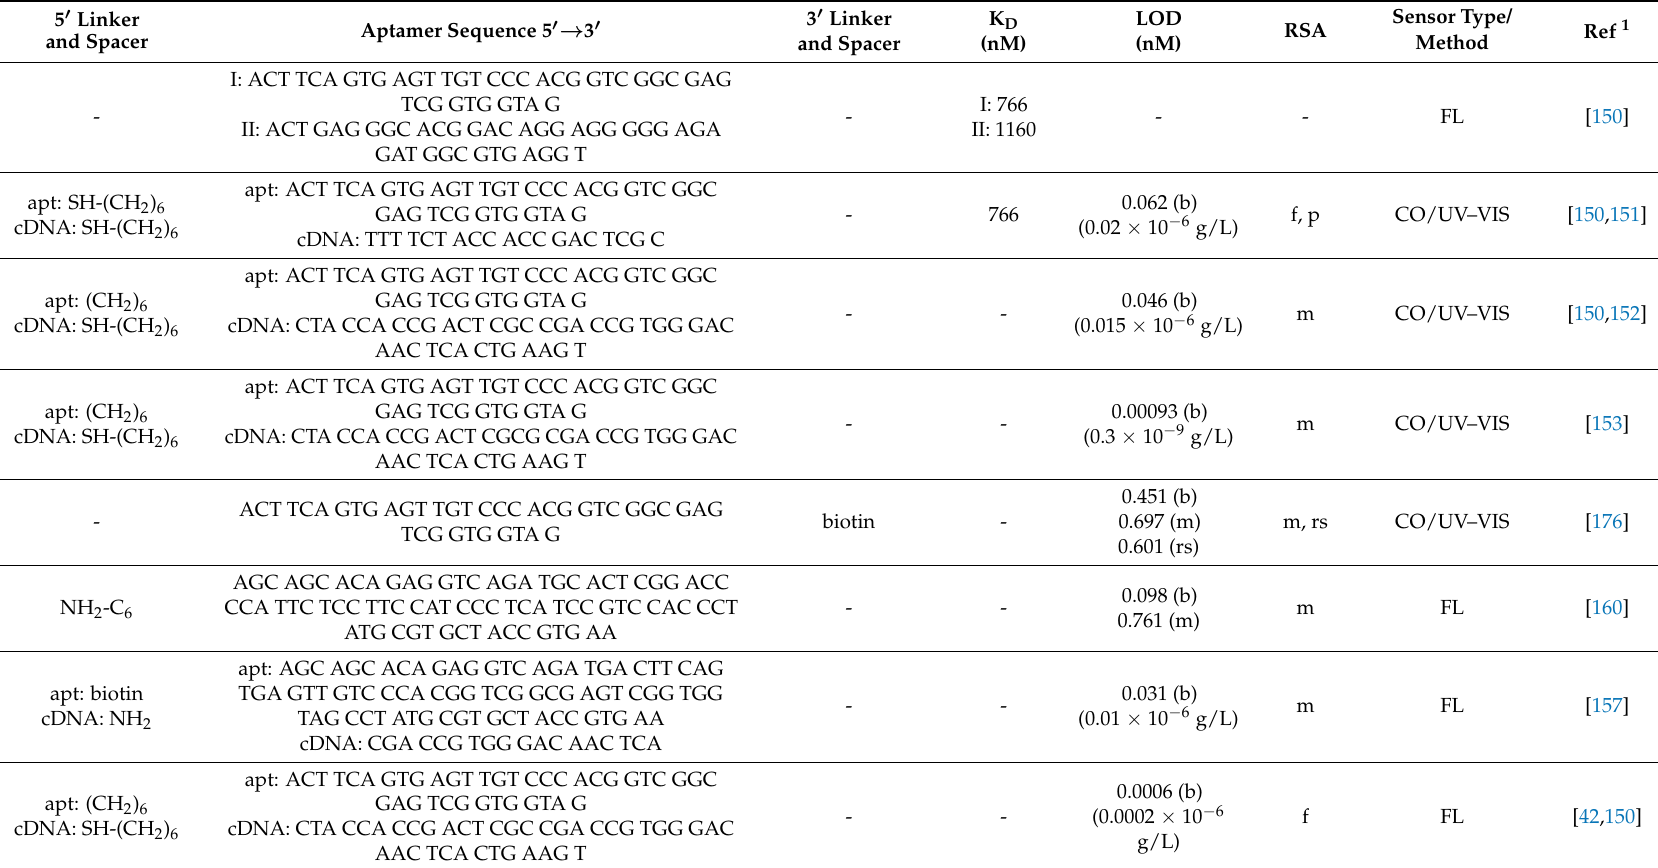
Table 9. Aptamer sequence, dissociation constant (K D ), limit of detection (LOD), real sample analysis (RSA), and realized sensor type and measuring method for chloramphenicol, mentioned in the corresponding references (Ref). AEC = amperometric electrochemical, apt = aptamer, b = buffer, cap = capture probe, cDNA = complementary DNA, CO = colorimetric, d = drugs, DPV = differential pulse voltammetry, ECL = electrochemiluminescent, EIS = electrochemical impedance spectrometry, f = fish, FL = fluorometric, h = honey, hs = human serum, IEC = impedimetric electrochemical, LSV = linear sweep voltammetry, m = milk, PEC = photoelectrochemical, p = pork, rs = rat serum, SPR = surface plasmon resonance, u = urine, and w =